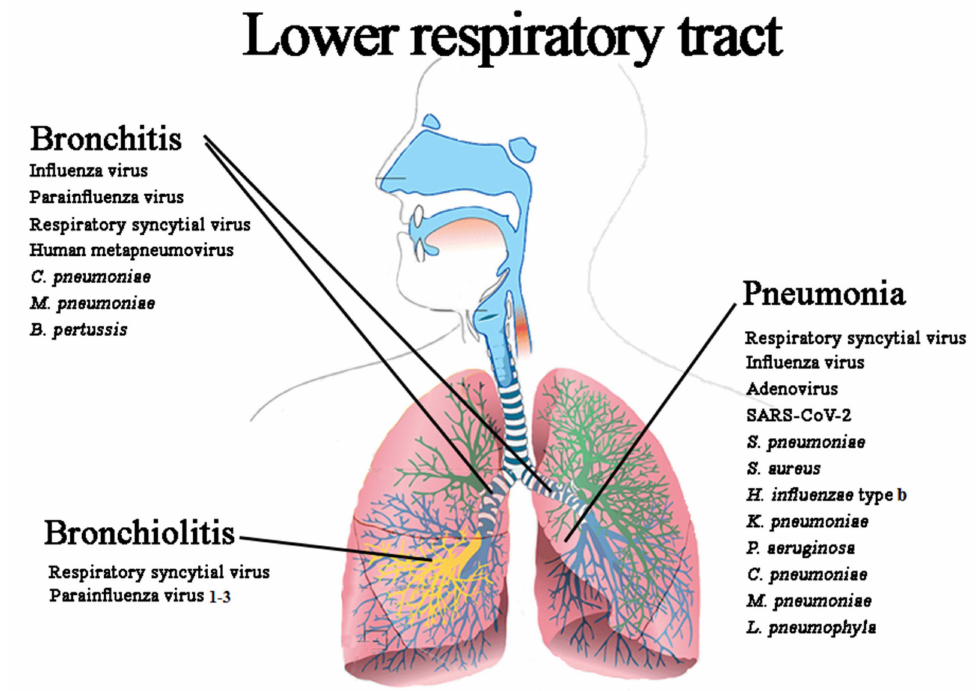
Figure 2. Classification of LRIs with the associated most relevant causative